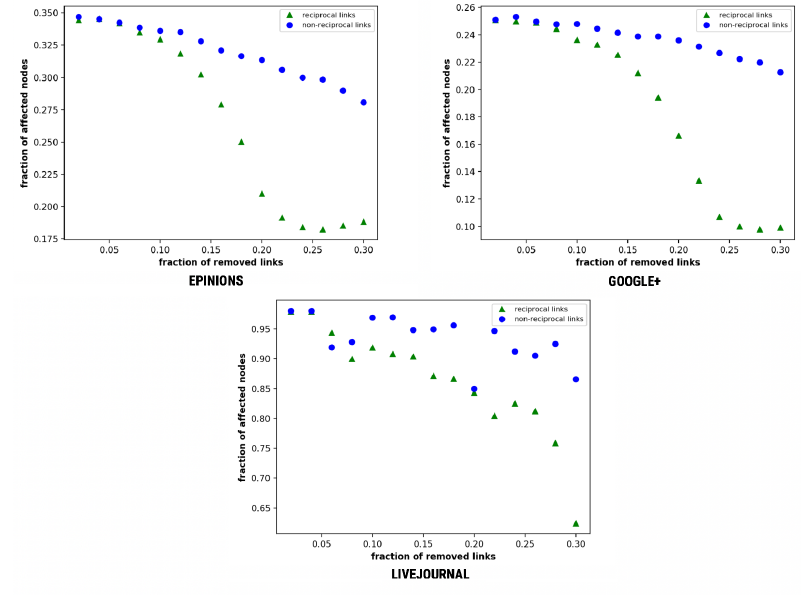
Figure 6. Edge diffusion—fraction of affected nodes as a function of the fraction of removed